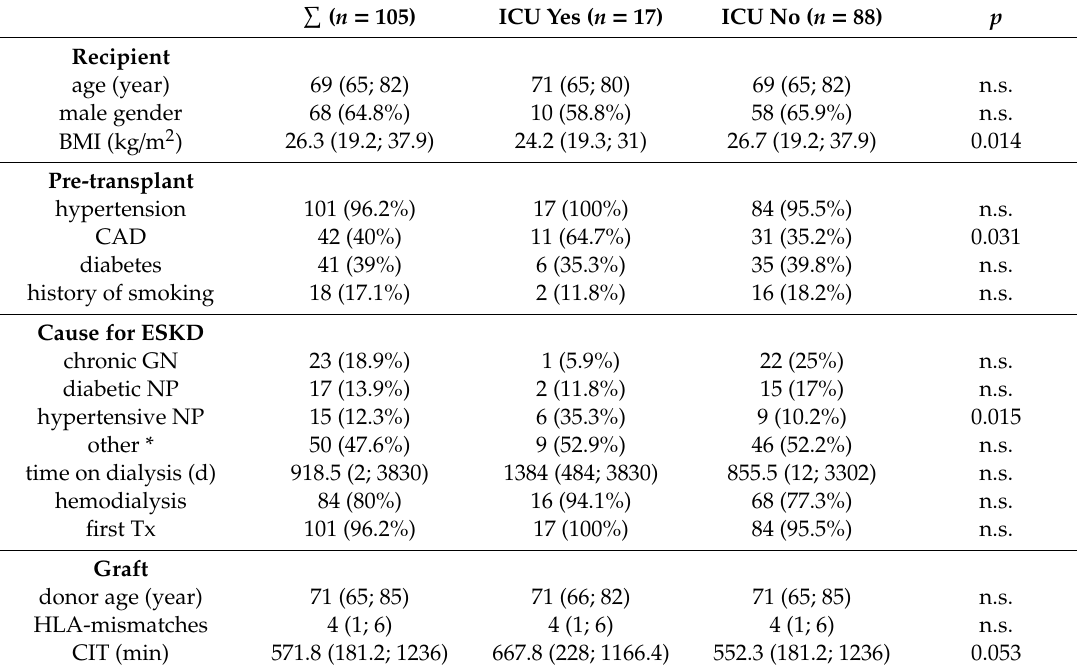
Table 1. Comparison of patient characteristics with or without ICU stay after kidney transplantation in the ESP